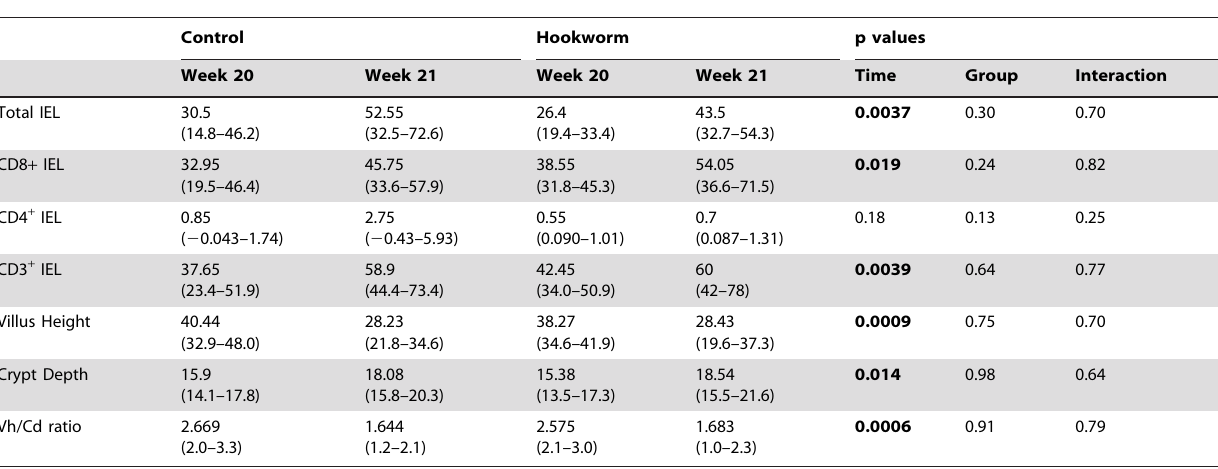
Table 2. Duodenal cellular responses following in vivo gluten